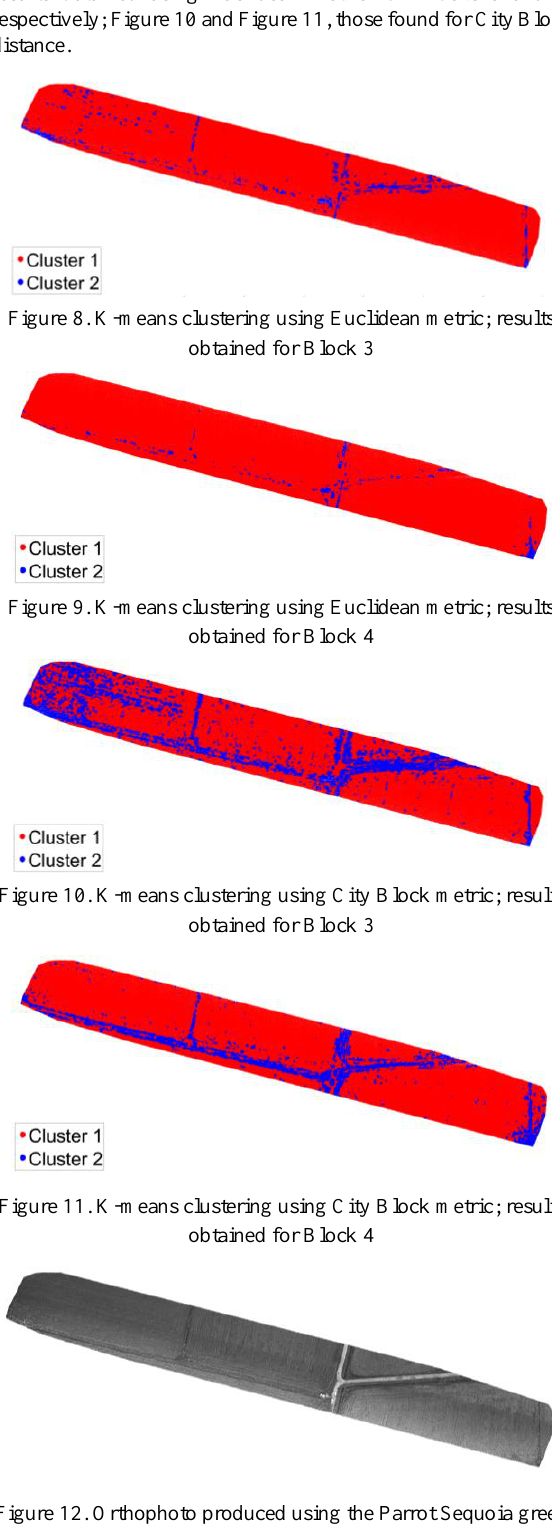
Figure 12. Orthophoto produced using the Parrot Sequoia green band (Block3)